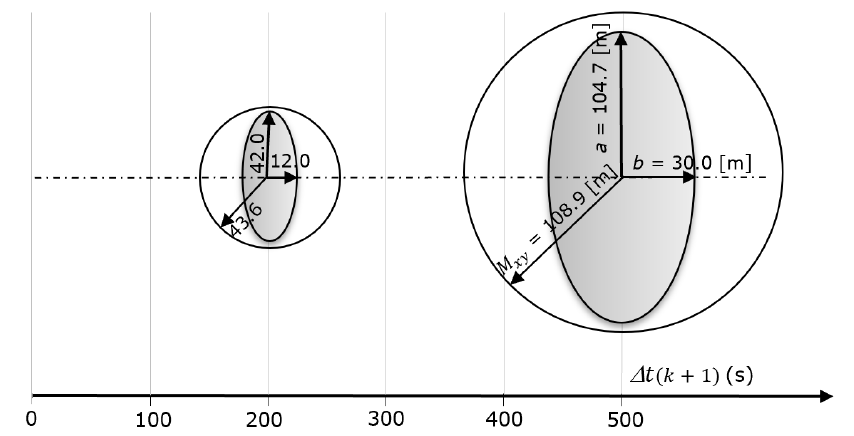
Figure 4. Change in mean error and mean error ellipse after SV travels 1200 m and 3000